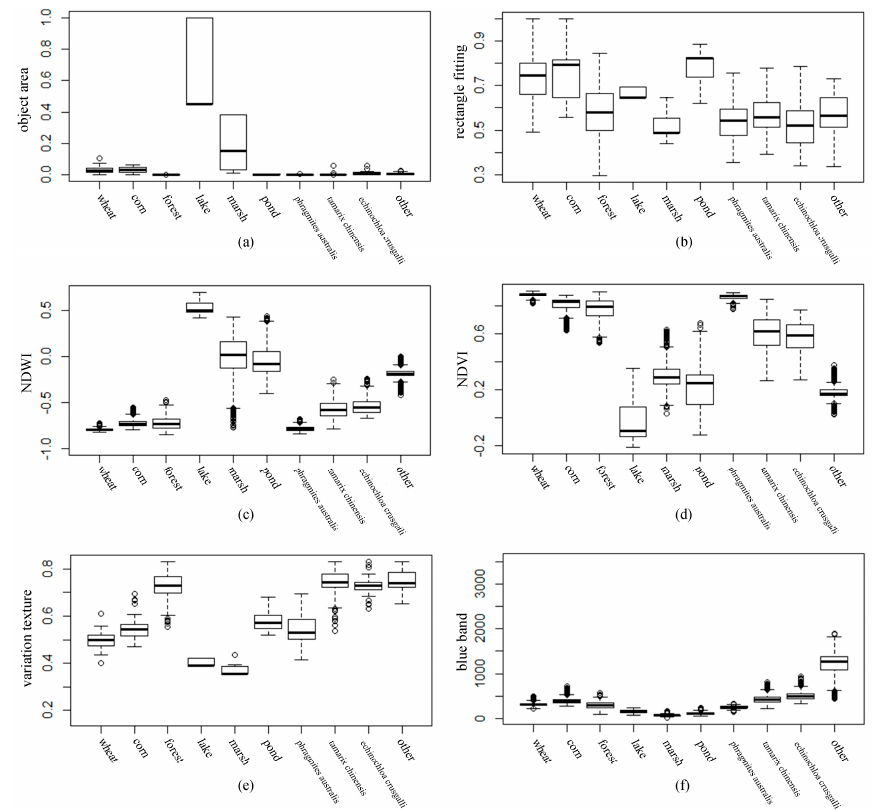
Figure 5. The feature distribution in different land cover types ( a ) normalized area; ( b ) normalized rectangle fitting; ( c ) normalized difference water index (NDWI); ( d ) normalized difference vegetation index (NDVI); ( e ) normalized variation texture; ( f ) 10,000 × reflectance of Pléiades-1B blue band).